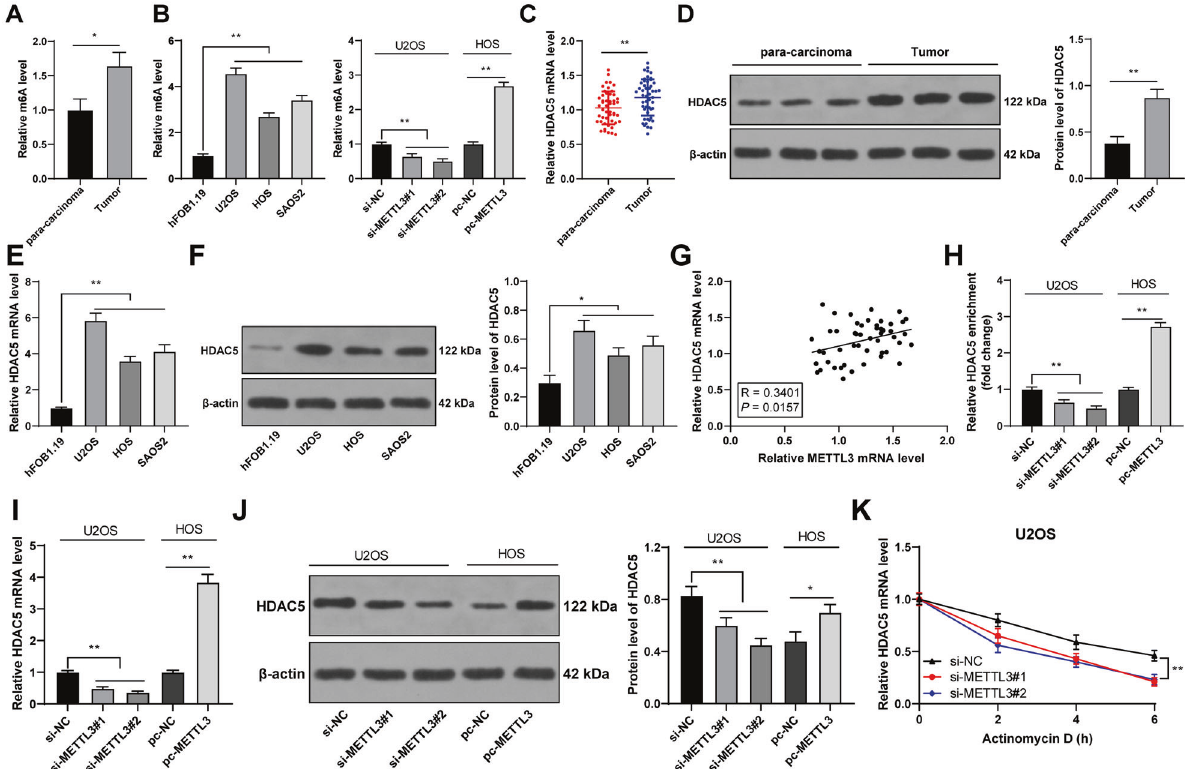
OS tissues was analyzed using Pearson correlation analysis. H The m 6 A modi fi cation level of HDAC5 mRNA in OS cells after intervention with METTL3 expression was detected using MeRIP-qPCR. I – K HDAC5 expression and stability in OS cells after intervention with METTL3 expression was measured using RT-qPCR and western blot. N = 50. The cell experiment was repeated three times independently. Data in panels A , B / D – F / H – K are presented as mean ± standard deviation. Data in panel C were analyzed using paired t -test and data in panels A / D were